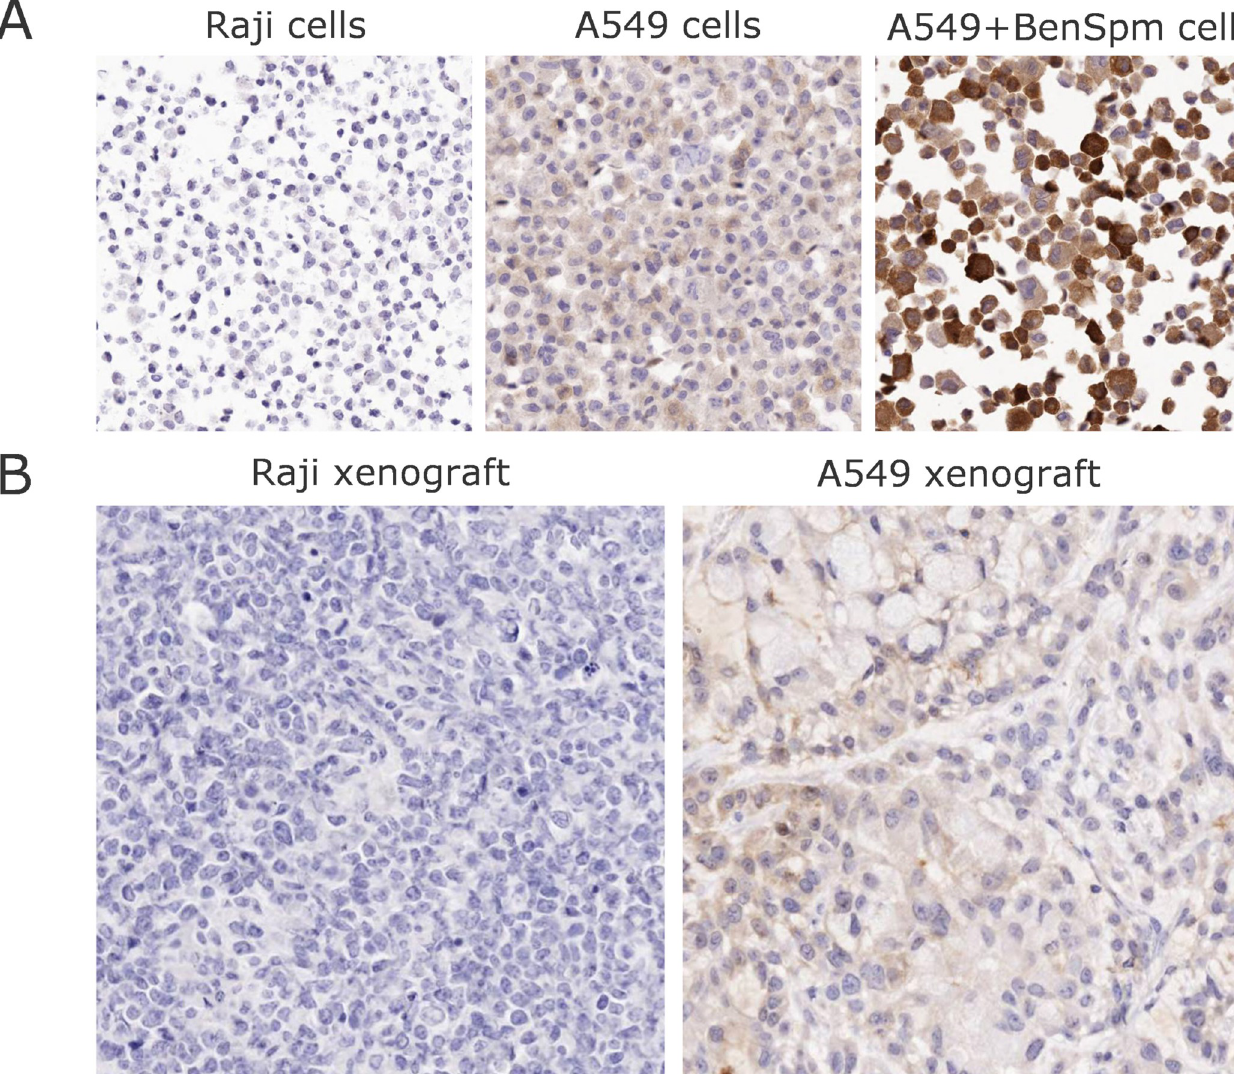
Fig 8. Immunohistochemistry using SMAB10. Images of hSMOX staining on paraffin embedded A549 cells (A) and mouse xenograft tissues (B).